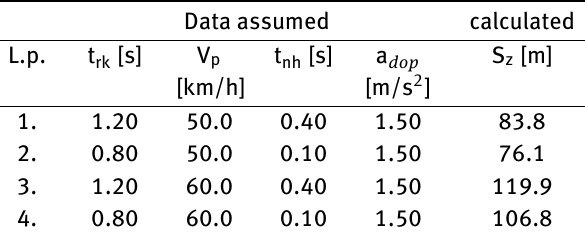
Figure 2: Diagram of the occurrence of the “trap area” for a city bus, before the intersection with signaling at the yellow signal displayed.